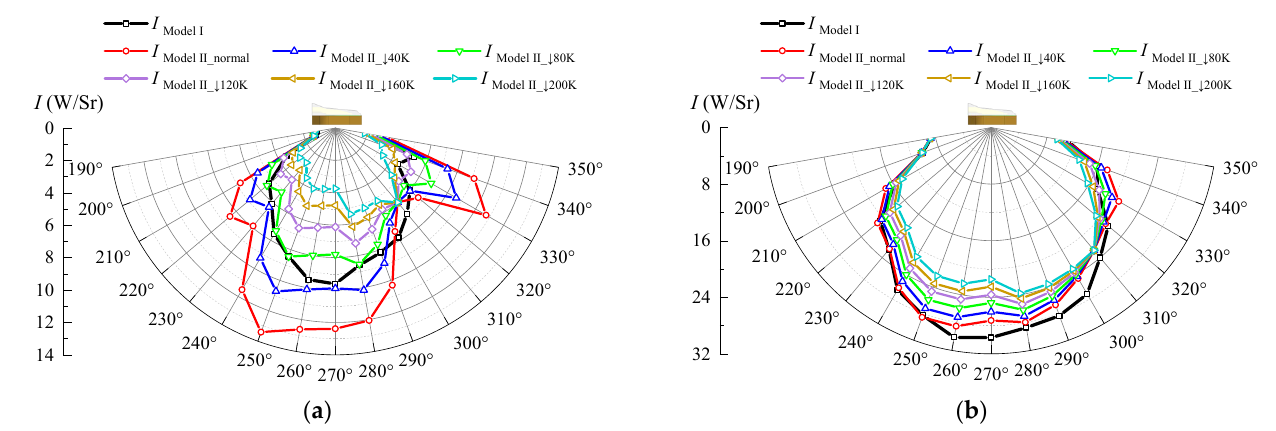
Figure 30. Total infrared radiation intensity of models after reducing the temperature of de fl ectors.